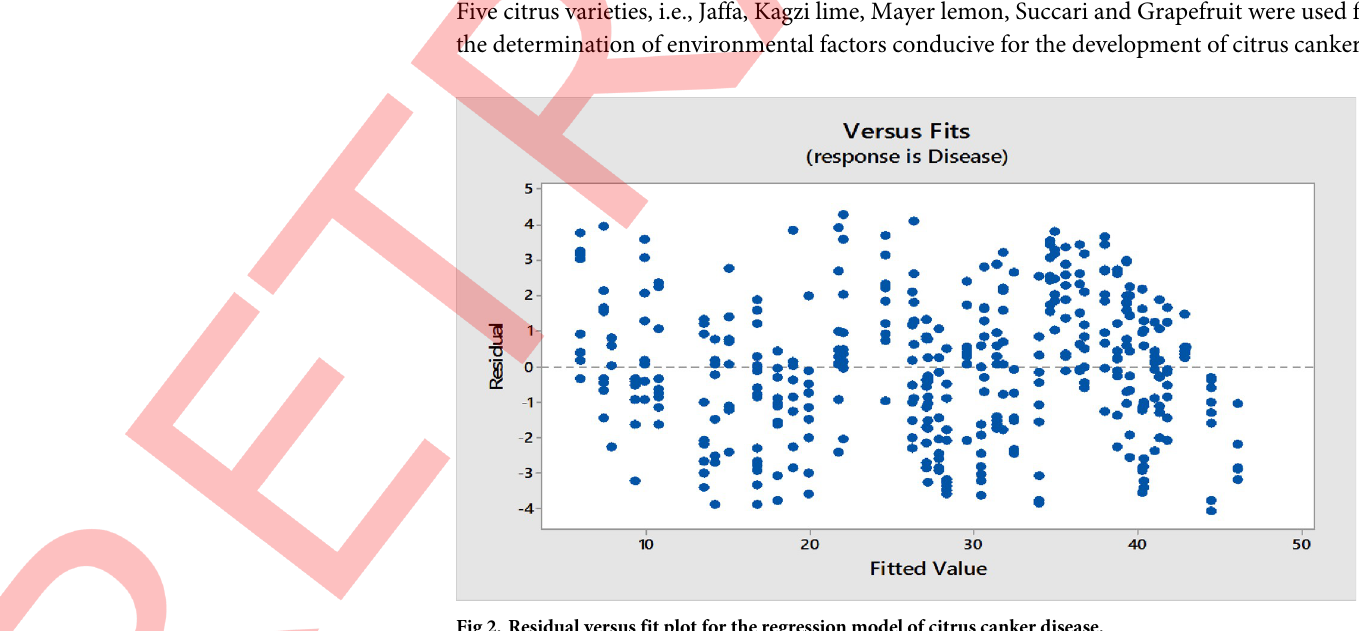
Fig 2. Residual versus fit plot for the regression model of citrus canker